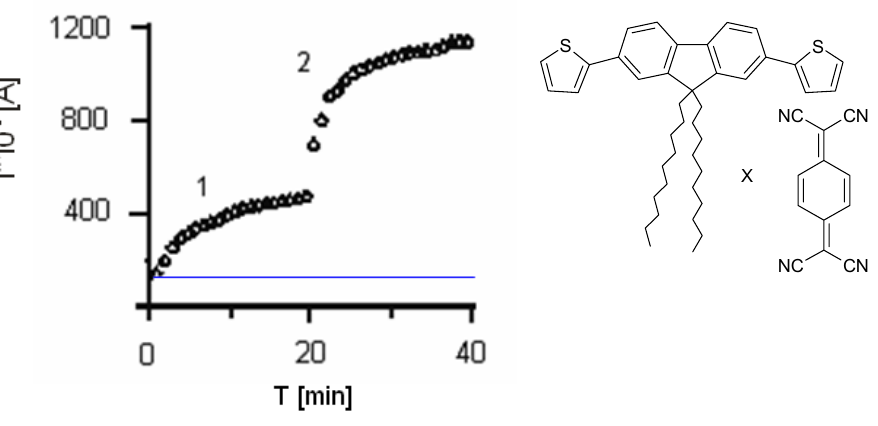
Figure 8. Conductivity response of a five layer LB film of 3 -TCNQ in the presence of NO The first and second admission of the gas, baseline signal-blue